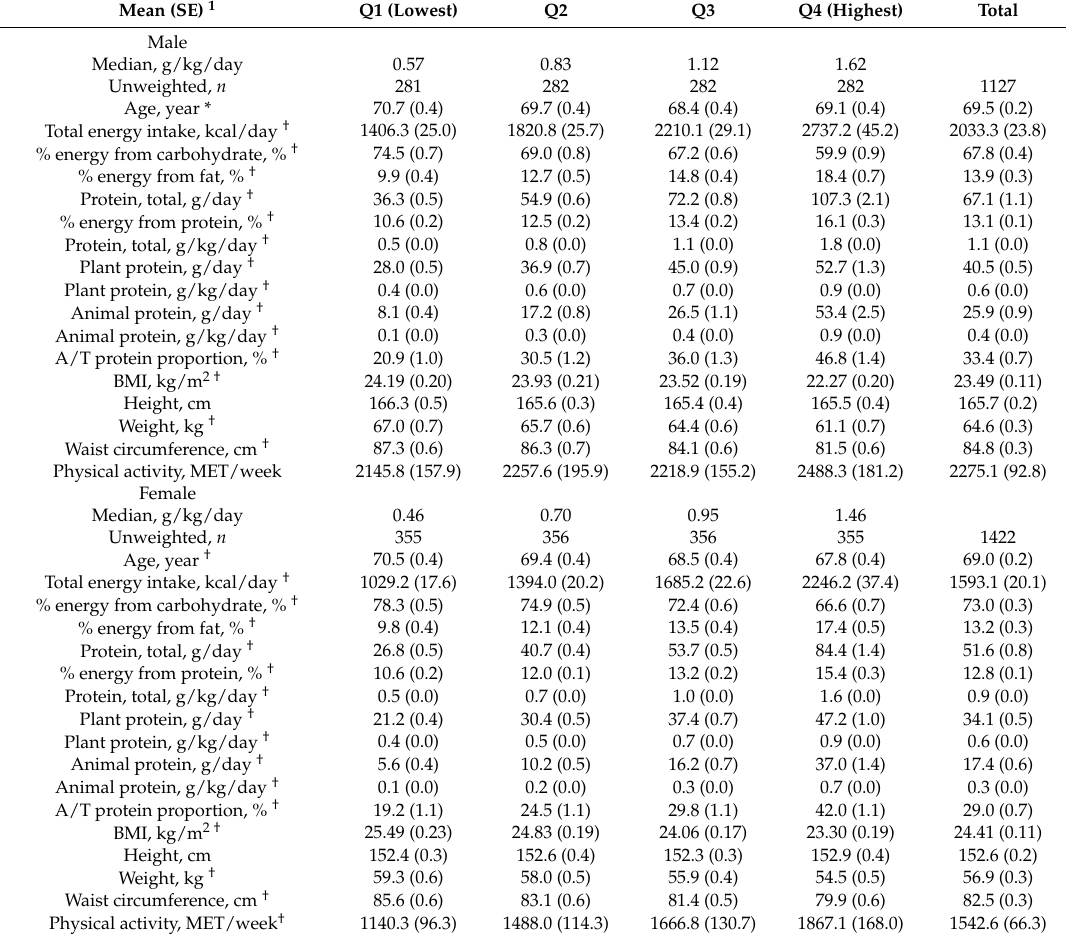
Table 2. Energy and macronutrient intake, anthropometric characteristics, and physical activity level by the quartiles of daily total protein intake per weight of Korean elderly